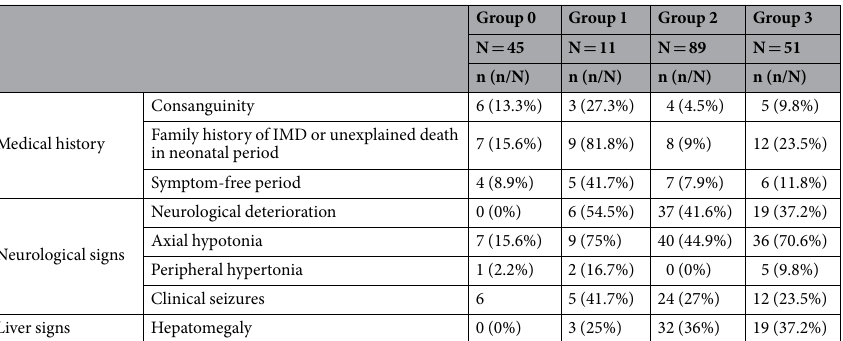
Table 3. Clinical characteristics in the 196 neonates for whom metabolic testings were performed. Group 0: neonates with a final diagnosis of transient disorder; group 1: neonates diagnosed with IMD confirmed by molecular testing; group 2: neonates suffering from a non-metabolic disease; group 3: neonates with chronic clinical abnormalities but for whom no diagnosis could be made.